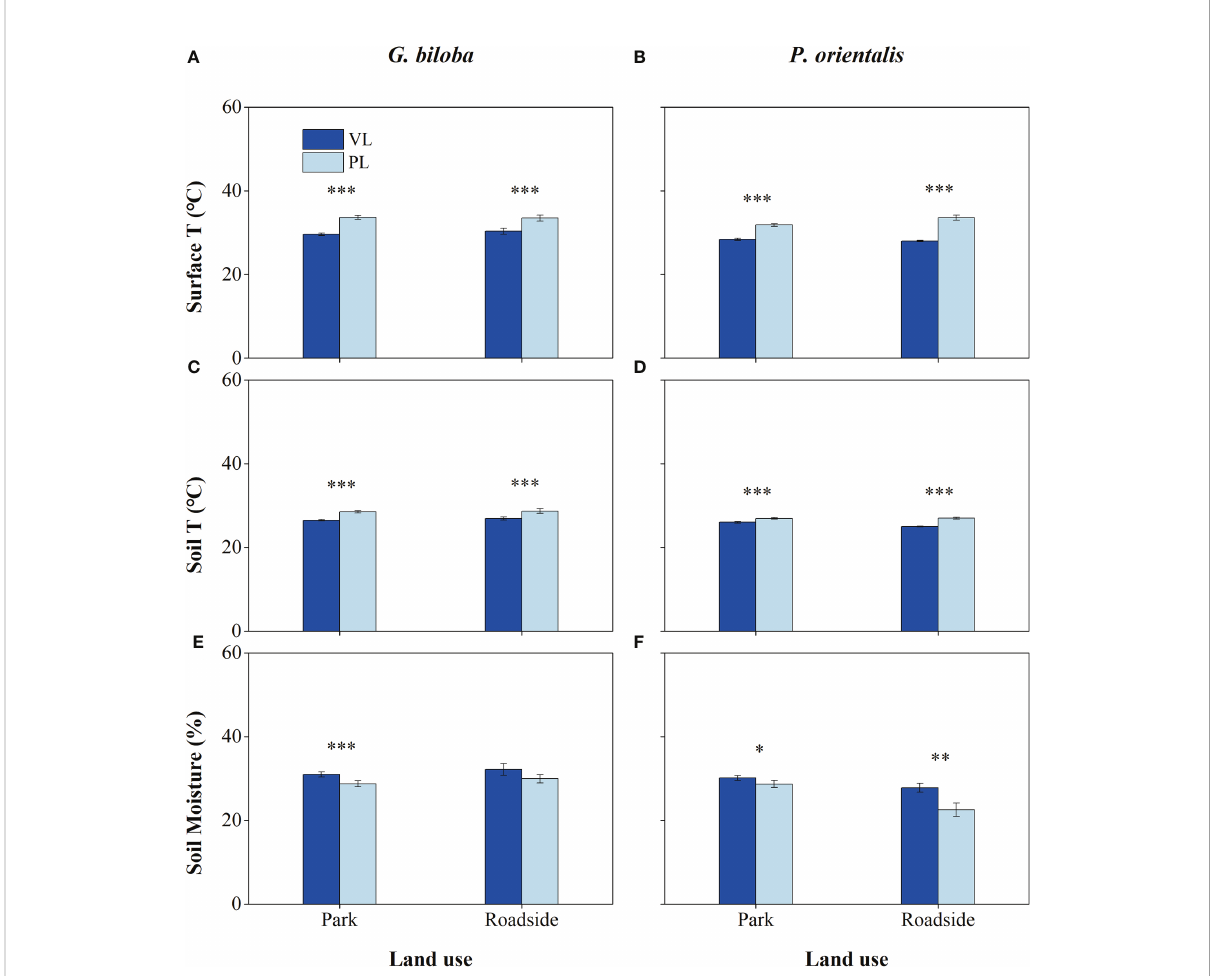
FIGURE 3 The surface temperature (A, B) , soil temperature (C, D) , and soil moisture (E, F) of the vegetated land (VL) and the paved land (PL) at the park and roadside for Ginkgo biloba and Platanus orientalis . Error bars indicate the standard error of the mean. *, **, *** indicate statistically signi fi cant differences between VL and PL at P < 0.05, P < 0.01, and P < 0.001,